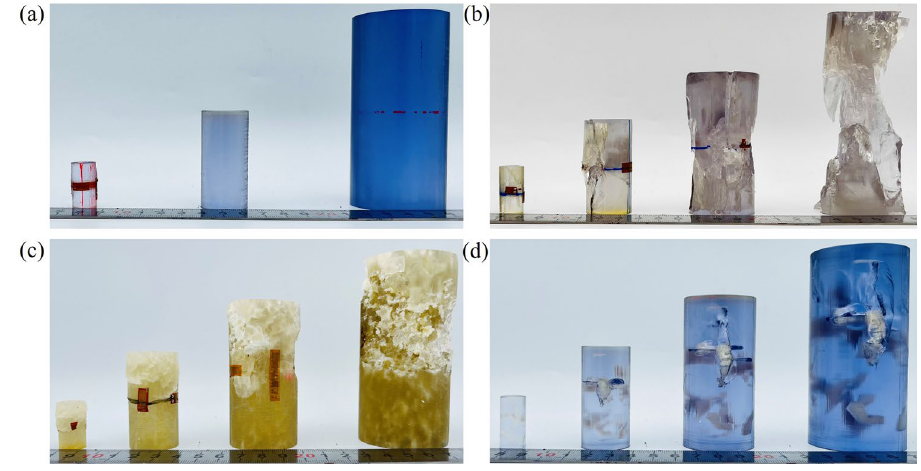
Fig. 6 Failure modes of different printed models. a Homogeneous model; b Fractured model with real cleavages; c Porous model with real pores; d Amplified porous